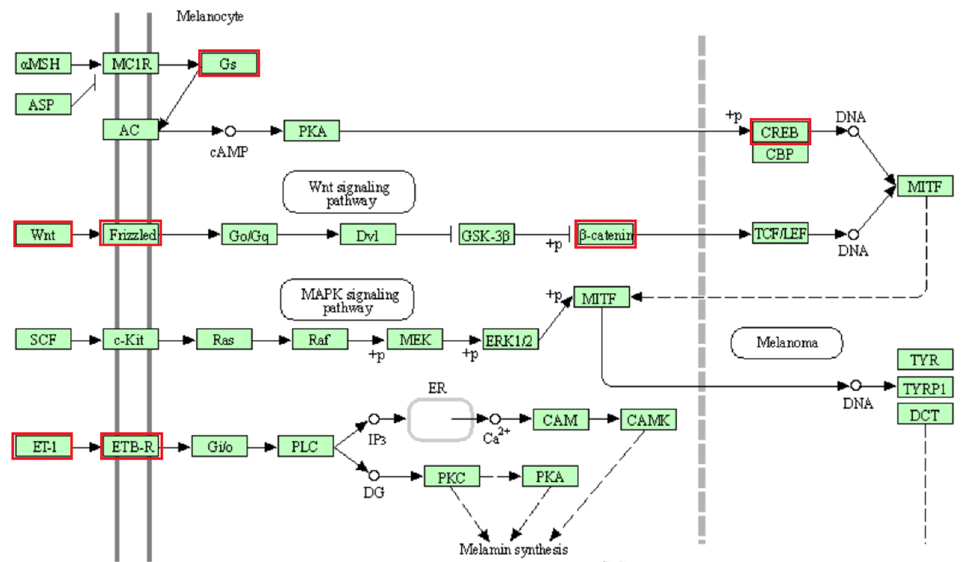
Figure 8. Melanogenesis pathway (KEGG database [76], map04916, truncated to the part relevant for this study). The genes belonging to the proteins highlighted in red were identified in selection signals specific for Balusha. Please note that name of the genes and the corresponding proteins are not always the same (e.g., Frizzled = FZD7, FZD5). All involved proteins are displayed in light green boxes.